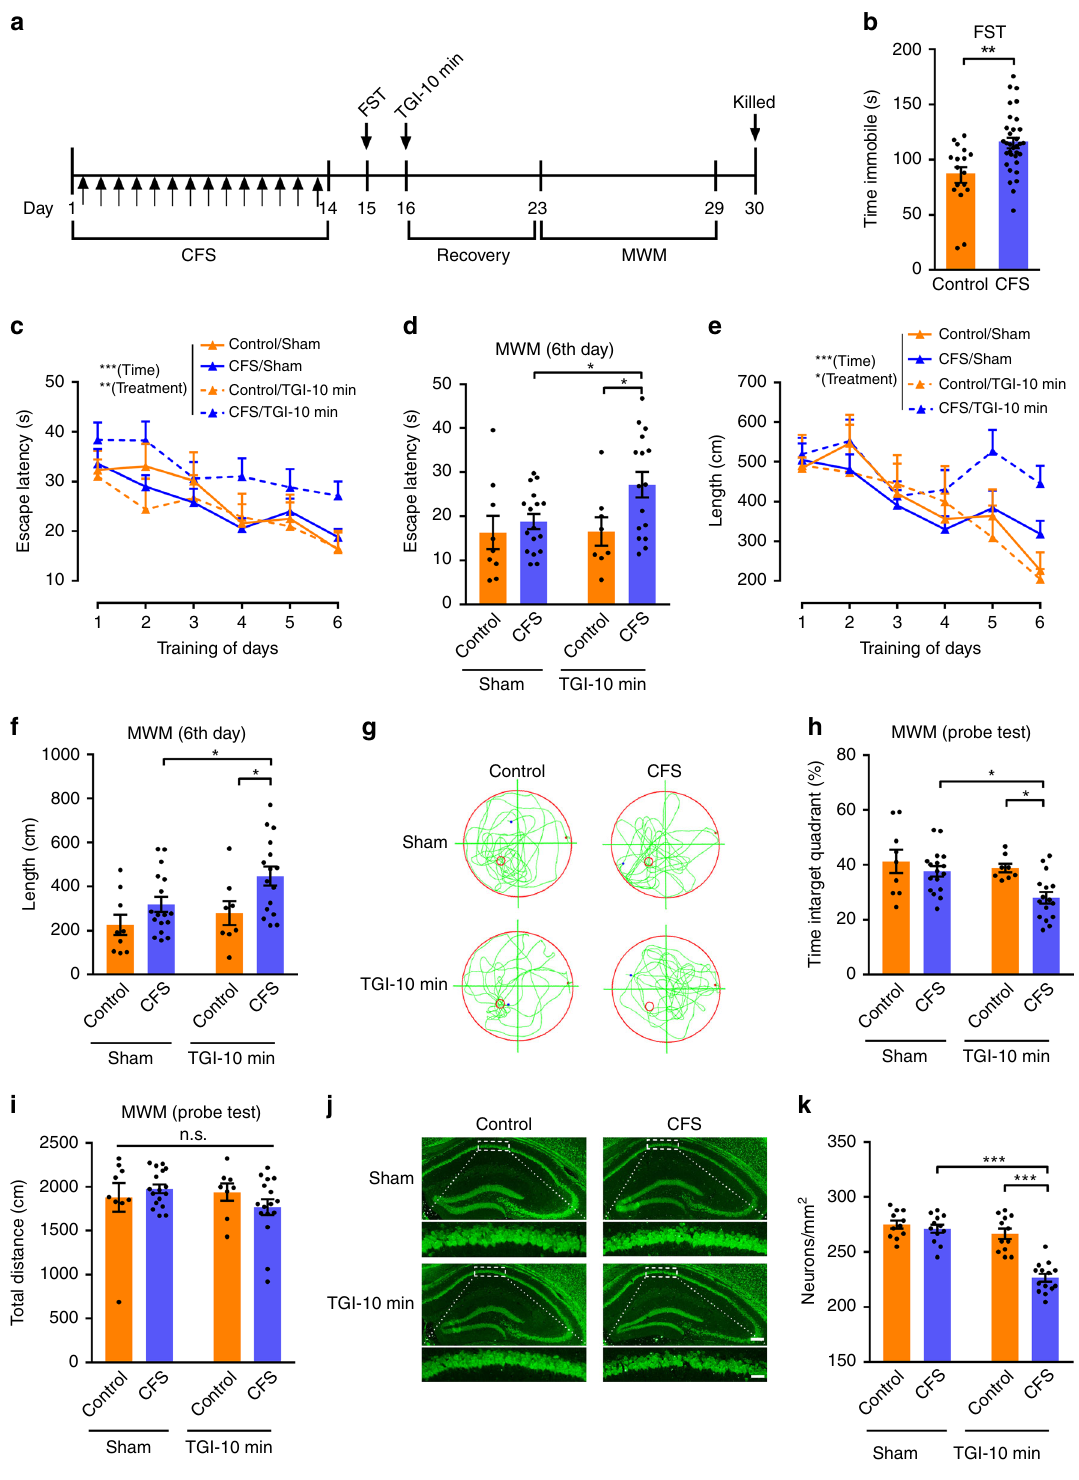
fl uorescence in the brain-wide axonal arbours of each TH + neuron population. After a 4-week recovery period, mice were subjected to a continuous 10 days of CSDS (Fig. 4c). Next, we quanti fi ed the EYFP-positive axonal output patterns of the area population throughout the brain. The series of coronal sections for LC-TH + neurons in targeted cases and the average normal- ised fraction of EYFP + axons for each brain region are displayed